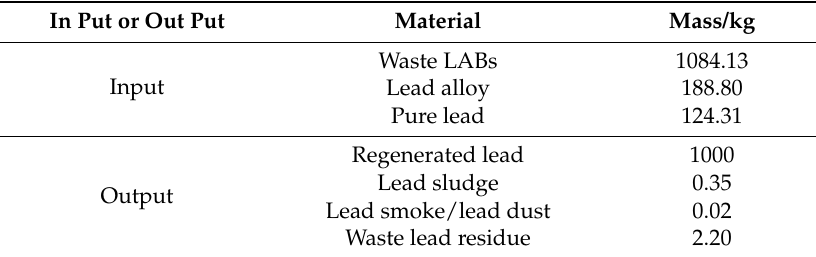
Table 1. The input and output for 1 t of regenerated